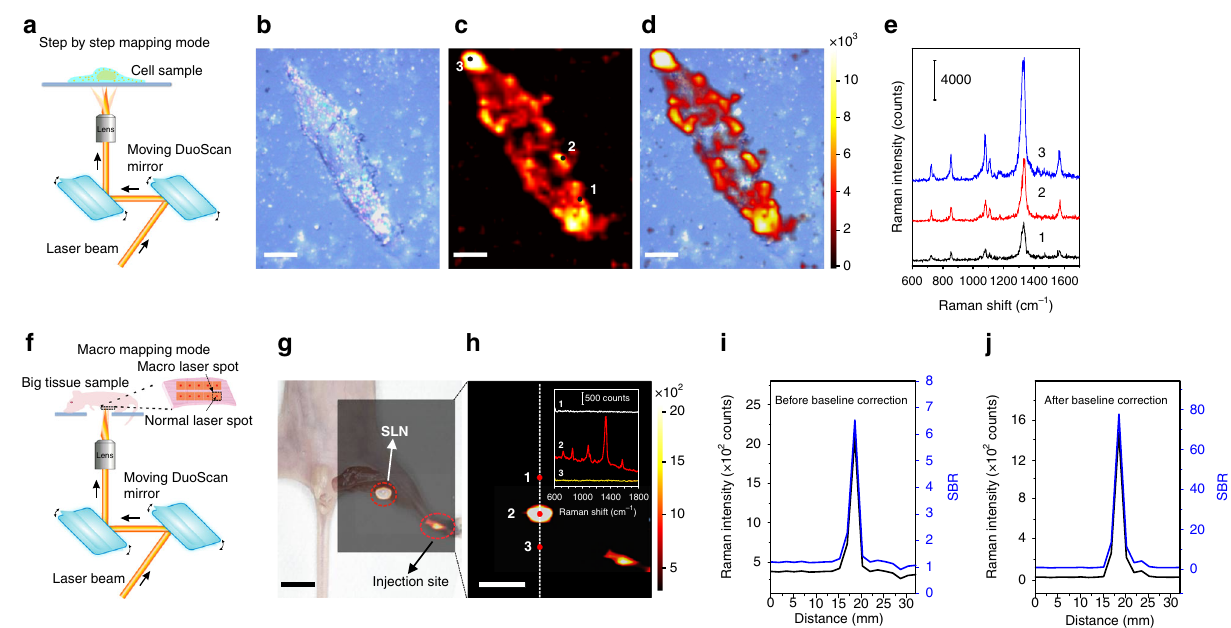
Fig. 5 High-speed and high-contrast wide-area Raman imaging. a Schematic illustration of the stepping scan mode for high-speed cell Raman imaging. b Bright- fi eld image, c Raman image, and d the overlay image of a single H1299 cell. The Raman image is obtained within 6 s (50 × 50 pixels) with a laser power of 370 μ W and a 0.7 ms acquisition time per pixel. Scale bars in panel b – d are 10 μ m. e Three representative SERS spectra obtained from different points in panel c . f Schematic illustration of the Macro scan mode for wide-area tissue imaging. ( g , h ) High-contrast and wide-area in vivo Raman image (3.2 × 2.8 cm 2 ) of the hind-limb popliteal lymph node after injection of P-GERTs. The Raman image was obtained within 52 s (20 × 20 pixels) with a laser power of 370 μ W and acquisition time of 0.7 ms per pixel. Scale bars in panel g and h are 1 cm. The inset in h shows Raman spectra at the SLN in situ (point 2), adjacent tissue (point 1) and surrounding environment (point 3). All Raman images are plotted using the Raman band at 1340 cm − 1 . The intensity and signal-to-background ratio (SBR) of the Raman signal (1340cm − 1 ) cross-section from top to bottom marked by the white dashed line in h ( i ) before